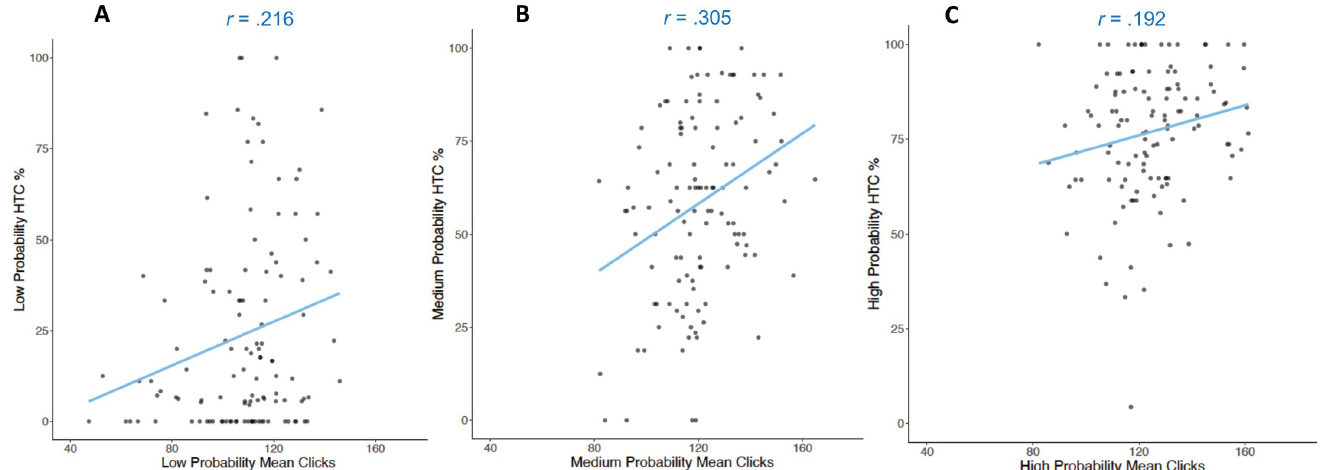
Fig 7. Pearson correlations between task performance in both tasks in Study 1. Correlations between the percentage of hard-task-choices (HTC %) within the original EEfRT and the mean number of clicks within the modified EEfRT for A: Trials with low probability of reward attainment (= 12%), B: Medium probability of reward attainment (= 50%) and C: High probability of reward attainment (= 88%). All depicted correlations were significant with p < .05.